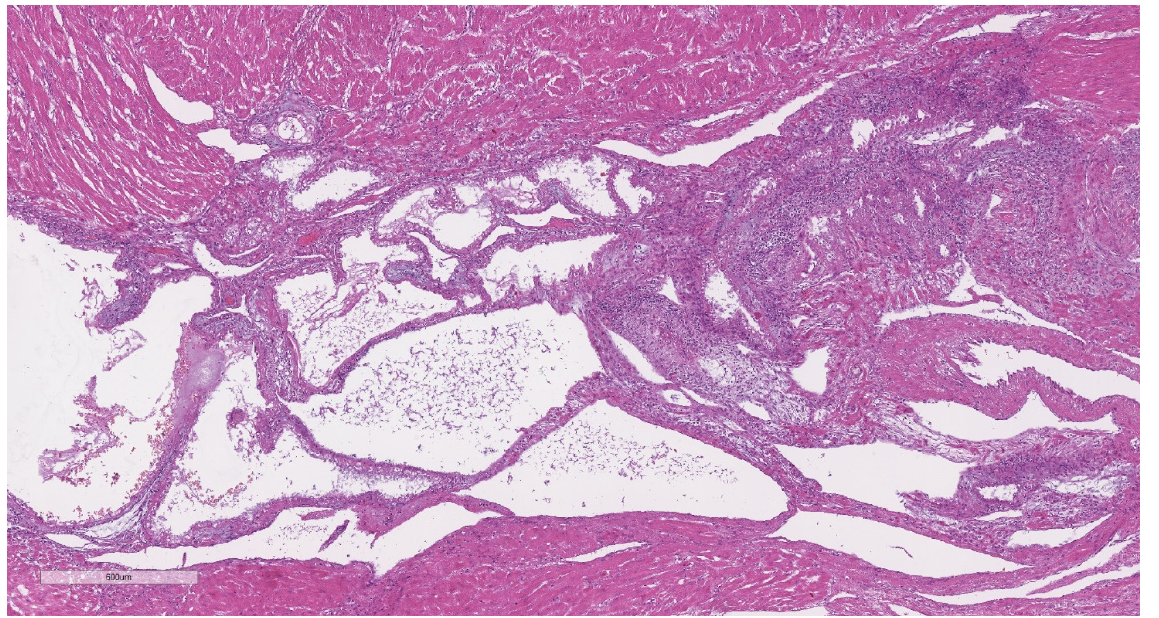
Figure 4. H&E, 4×. The decidualized adenomyosis focus demonstrated large endometrial glands, some with ectasia, and an underlying endometrial stroma.